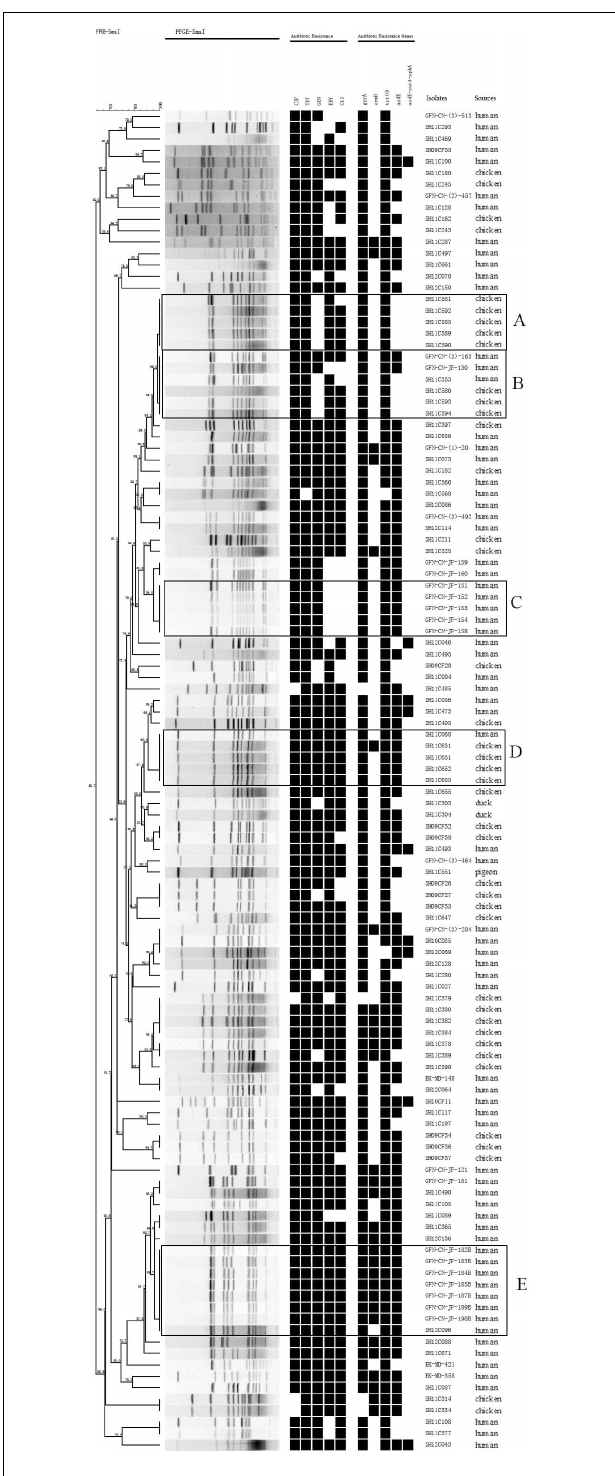
FIGURE 2 | Dendrogram of PFGE profiles among the 119 multidrug-resistant Campylobacter coli . PFGE assay resulted into 77 different patterns. Corresponding antibiotic resistant patterns, antimicrobial resistant genes or mutants were listed for each isolate. Five prevalent genotypes (A–E) were identified. CIP, ciprofloxacin; TET, tetracycline; GEN, gentamicin; ERY, erythromycin; CLI,